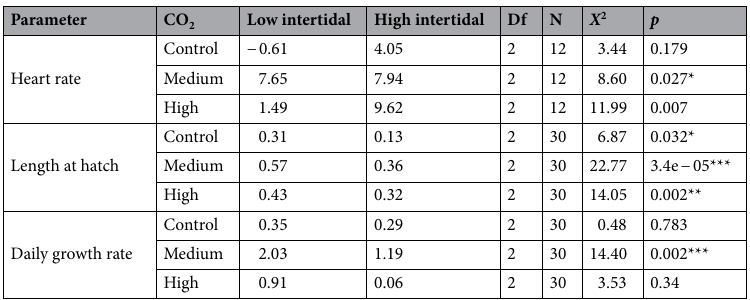
Table 2. Linear mixed model including replicate (hatchbox/jar) as a random factor, showing the main effect of CO 2 across intertidal treatments relative to the subtidal. Below are the summary of Chi square tests ( X 2 ) and p-value using the adjustment method Holm. N refers to number of embryos/larvae per treatment summed across replicates.